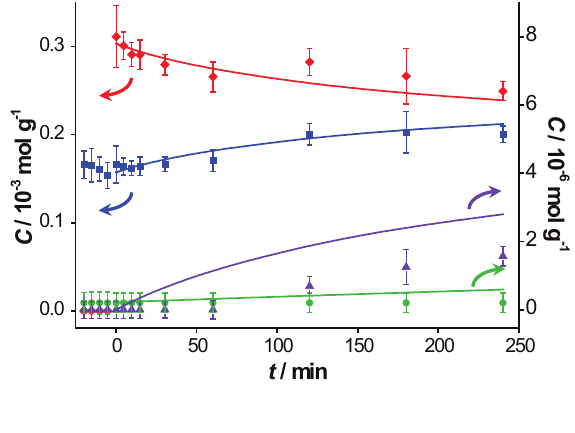
Figure 3. Catalyst performance after pre-addition of benzaldehyde. Concentration of ( ♦ ) benzyl alcohol, ( ■ ) benzaldehyde, ( ● ) benzoic acid and ( ▲ ) benzyl benzoate vs. reaction time for catalytic reaction over fresh AUROlite ™ . Benzaldehyde was introduced 20 min before benzyl alcohol was added. Reaction conditions: T = 80 °C, 0.8 g AUROlite ™ , C BnOH, = 3.0 × 10 −4 mol · g − 1 , C = 1.7 × 10 − 4 mol · g − 1 , in 80 mL of toluene, t=0 BnO, t<0 200 mL · min − 1 air flow. Concentrations are expressed in moles per unit mass of liquid in the reactor (mol · g − 1 ). The symbols with error bars are the experimental results and the lines represent the kinetic